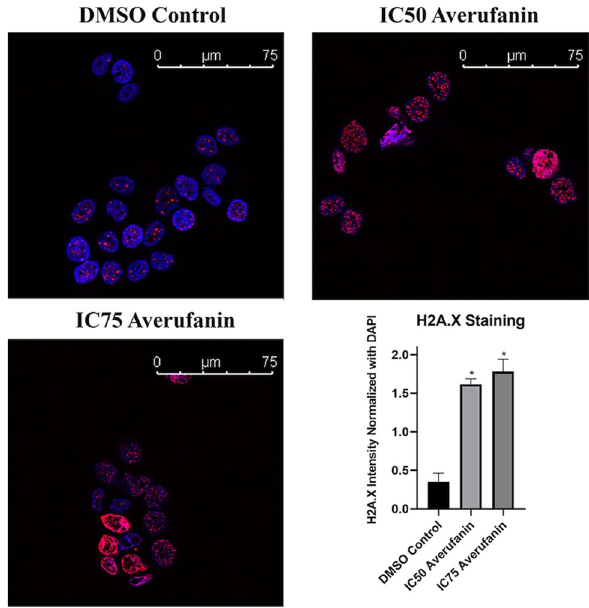
Figure 6. γ-H2Ax staining showed accumulation of DNA damage upon Averufanin treatment. Human breast cancer cells (T47D) were treated with ( A ) DMSO, ( B ) IC 50 dose Averufanin, or ( C ) IC 75 dose Averufanin for 48 h and stained with anti-γ-H2Ax and DAPI. Blue represents DAPI and red represents γ-H2Ax which increases as a DNA damage response (DDR). Images were obtained from the confocal microscopy through LasX and dye intensities were evaluated with ImageJ. H2A.X intensities were normalized to DAPI, graphics and statistical analysis were conducted with GraphPad PRISM. Two-tailed, unpaired t-test was applied between DMSO Control and treatment groups (*p <